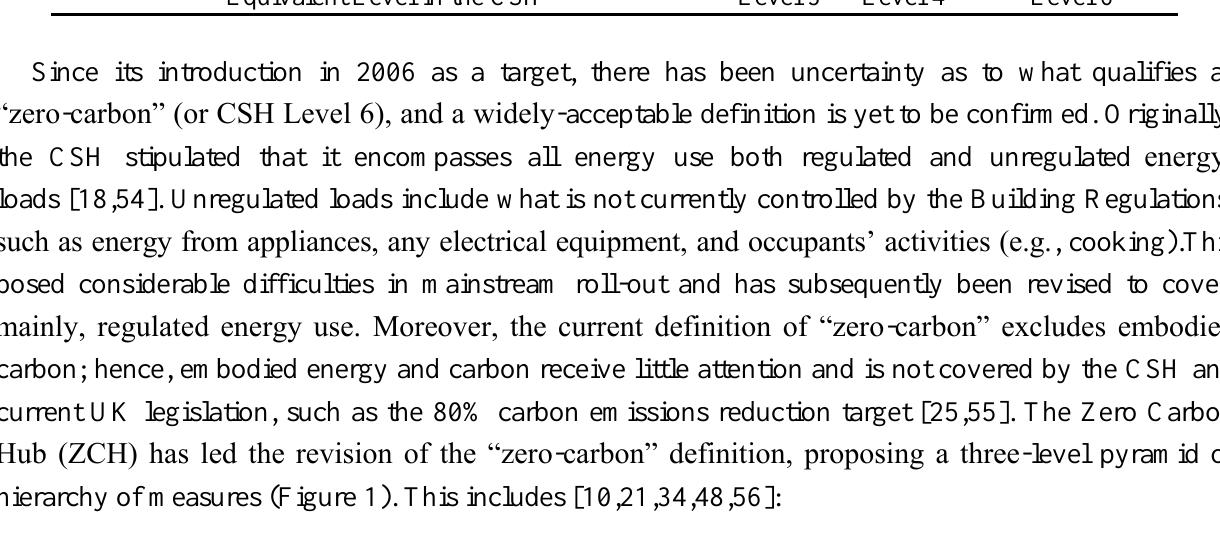
Figure 1. Hierarchical Approach to Zero-Carbon Homes ([21], p.6, p.8). Copyright Zero Carbon Hub